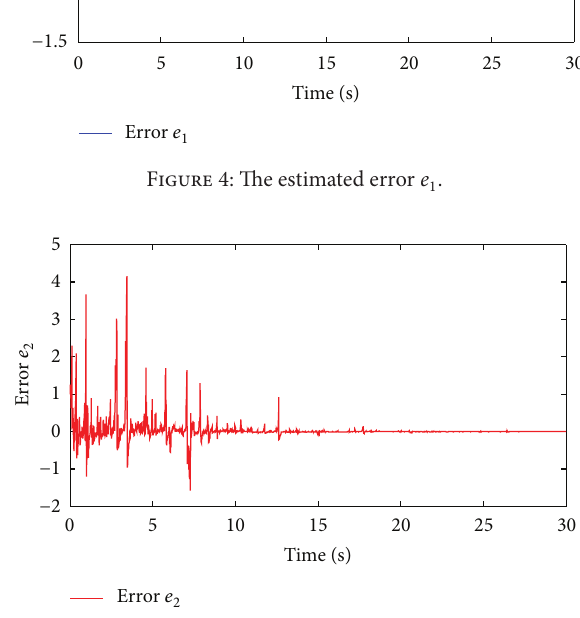
Figure 5: The estimated error e 2